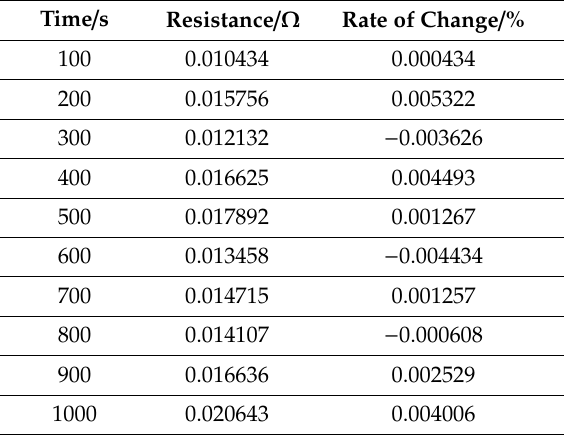
Table 2. The rate of change of the ohmic resistance.